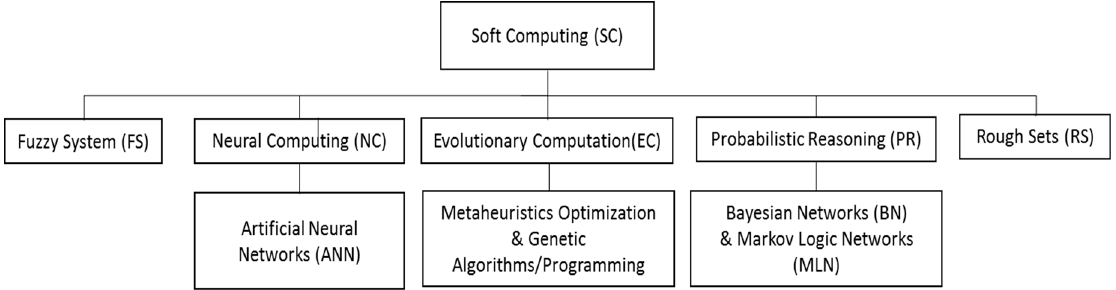
Figure 1. Taxonomy of soft computing methods used in making the initial database [47,48].